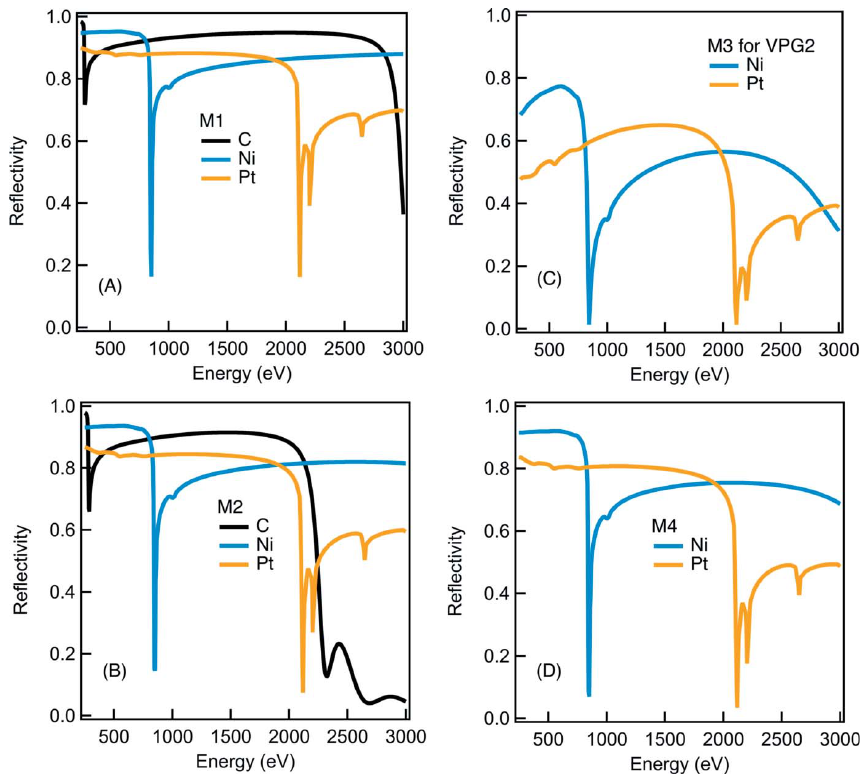
Figure 7 The simulated reflectivity of M1, M2, M3 and M4 mirrors as a function of energy. Note that the reflectivity of the M3 mirror is based on its corresponding (cid:3) angle for each energy position.